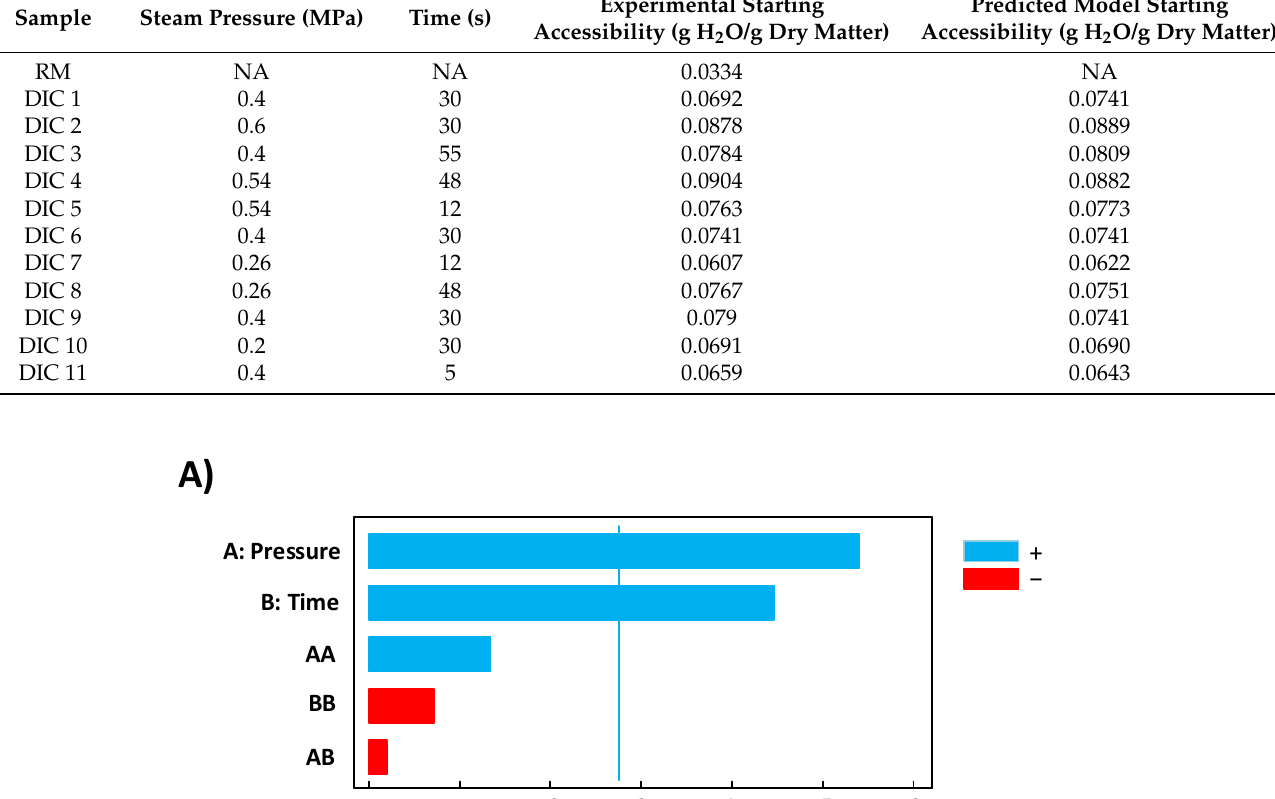
Table 5. Experimental data and predicted model results of the starting accessibility of mangoes.